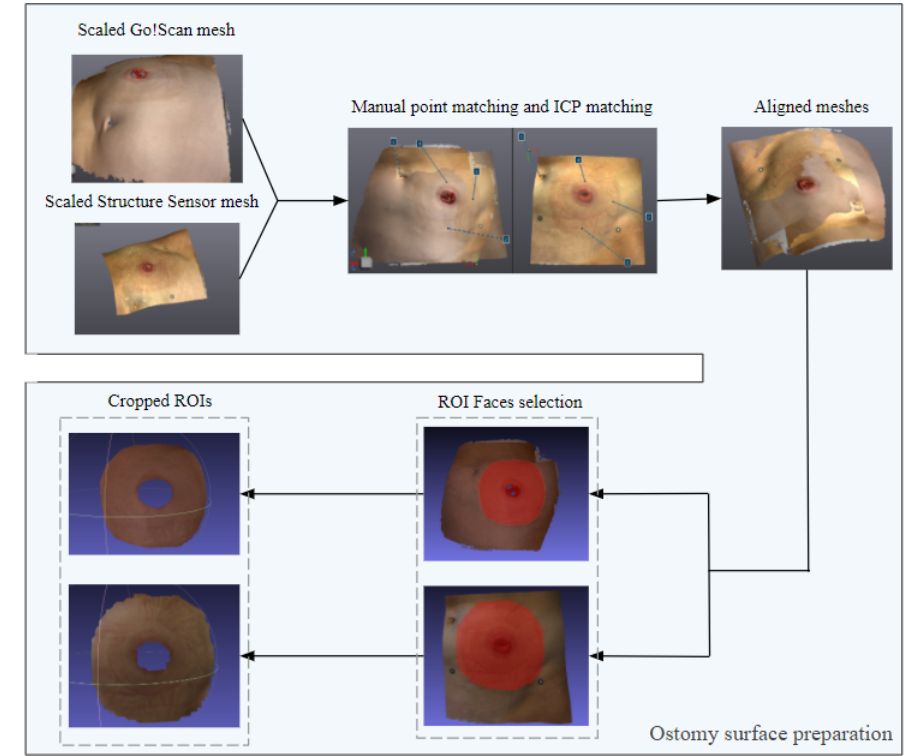
Figure 16. Stoma surface preparation